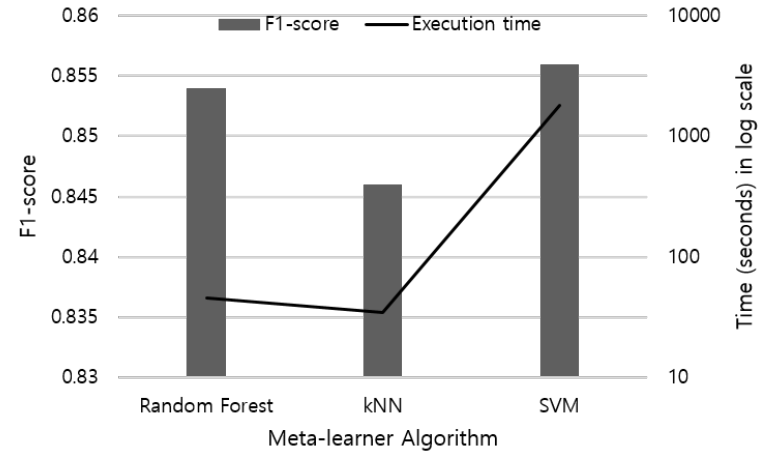
Figure 8. Performance and execution time of meta-learner models used in stacking